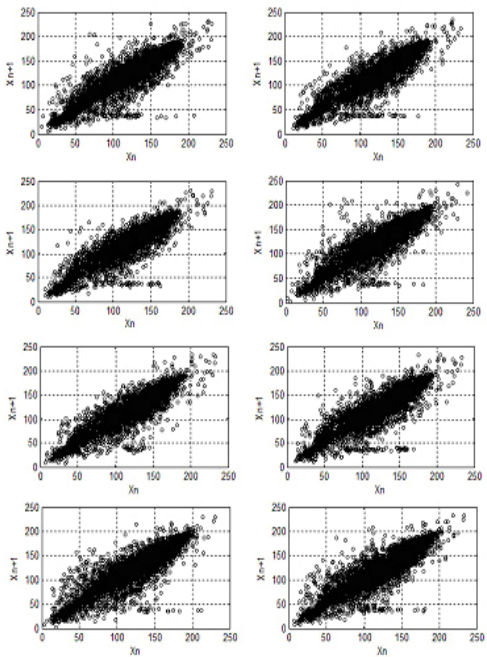
Fig. 7: State space map of eight instances of face image of the given person in AT & T face